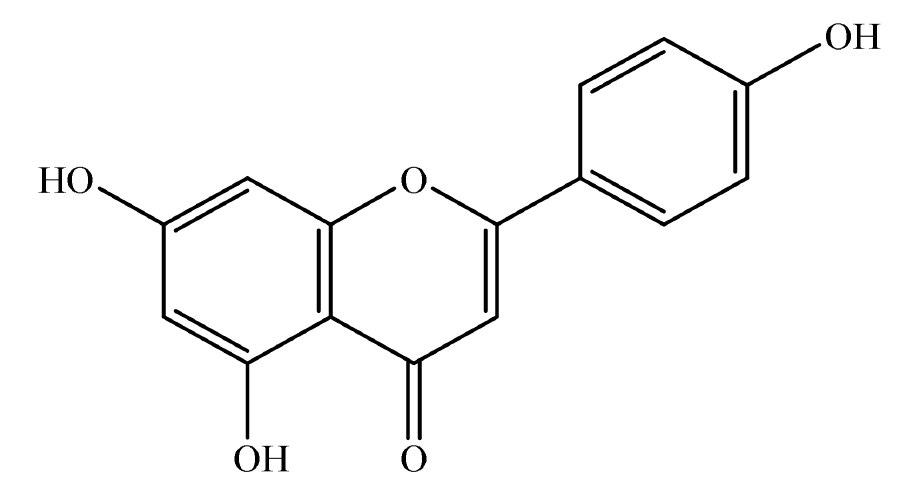
Figure 1. Chemical structure of apigenin (4 (cid:48)